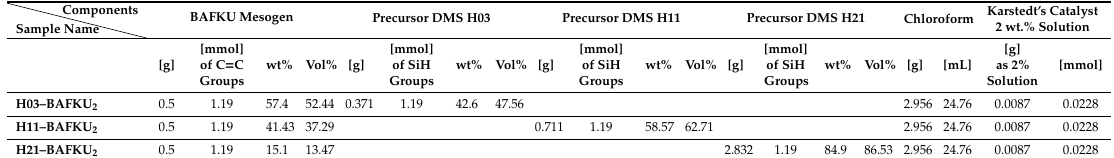
Table 1. Amounts of the components used in the synthesis of the main chain liquid crystalline copolymers based on polydimethylsiloxane (PDMS) and liquid crystalline (LC) mesogen. SampleNameComponents BAFKUMesogen PrecursorDMSH03 PrecursorDMSH11